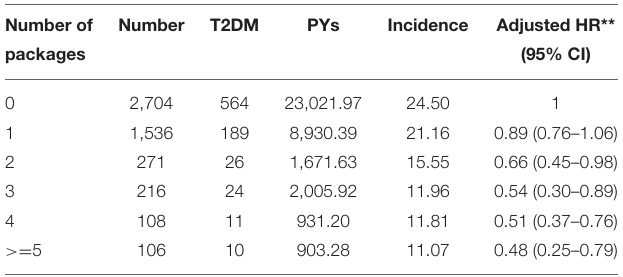
TABLE 3 | Risk of T2DM in association with number of packages of acupuncture treatment. Number of Number T2DM PYs Incidence Adjusted